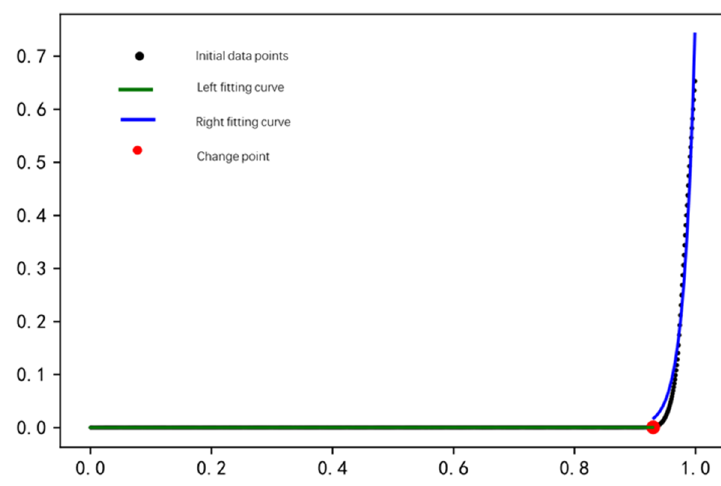
Figure 7. Bilateral fitting diagram.